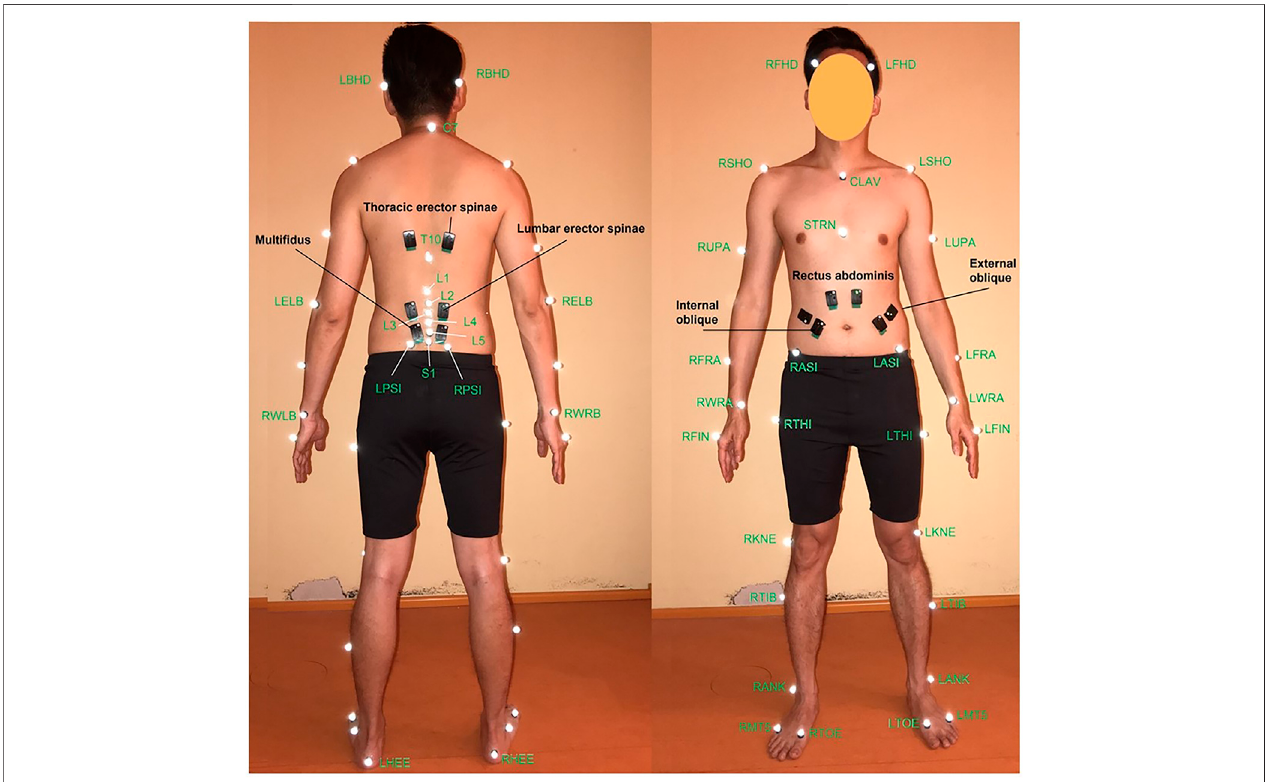
FIGURE 1 | Position of VICON markers (white ones) (Arshad et al., 2017) and EMG sensors (black ones) (McGill, 1991) from (left) back and (right) front views.